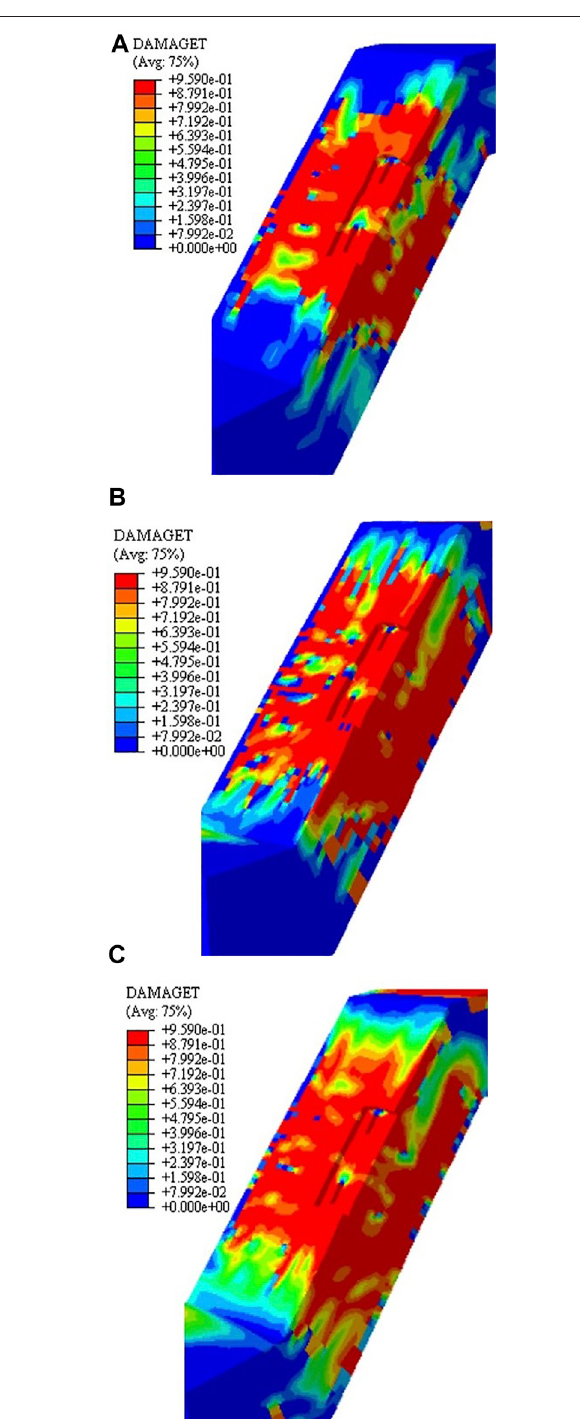
FIGURE 15 | Numerical damage distribution with different CSG: (A) C20-450 concrete component, (B) C40-450 concrete component, (C) C60- 450 concrete component.